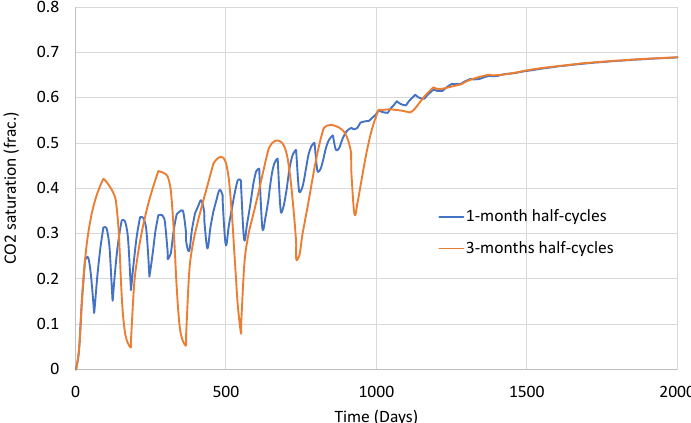
Figure 20. Fluctuation in CO 2 saturation in a near-well cell for the mid-reservoir injection scenario.